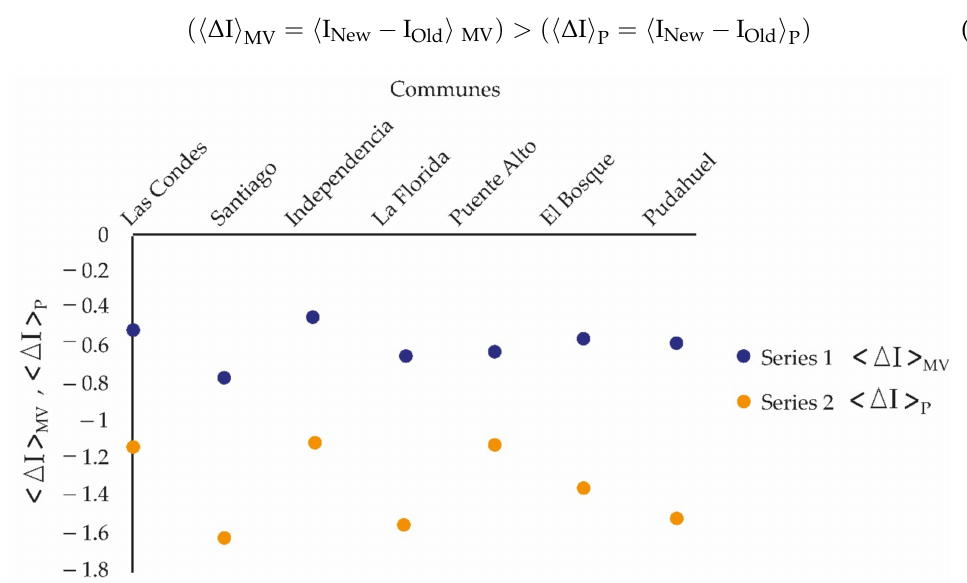
Figure 9. Information loss for (accumulated patients)/(meteorological variables) ( (cid:104) ∆ I (cid:105) ) and MV information loss for (accumulated patients)/(pollutants) ( (cid:104) ∆ I (cid:105) ) in the studied communes. P Calculating from Table 3 the averaged fractal dimension (D) [52] for (accumulated patients)/(meteorological variable), D AS/MV , and for (accumulated patients)/(pollutant), D AS/P , for each commune, Table 6 is obtained: Table 6. Fractal dimension (D = 2 – H, with H, the Hurst exponent) can be averaged for accumu- lated sick/meteorological variable (D AS/MV ) and for accumulated sick/pollutant (D AS/P ) for each commune. The fourth column represents the ratio between the third and second columns. Communes D AS/MV D AS/P D AS/P /D AS/MV LC 1.16 1.14 0.983 SANT 1.15 1.13 0.982 IND 1.17 0.957